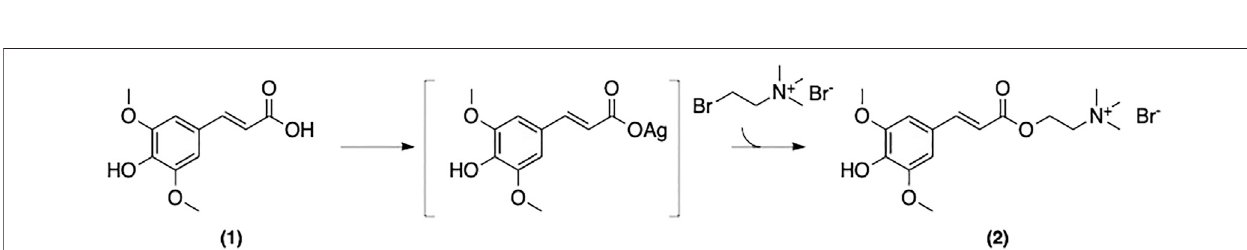
FIGURE 10 | Synthesis of SinA via a sinapoyl malate-piperidine intermediate following the Knoevenagel-Doebner condensation approach.